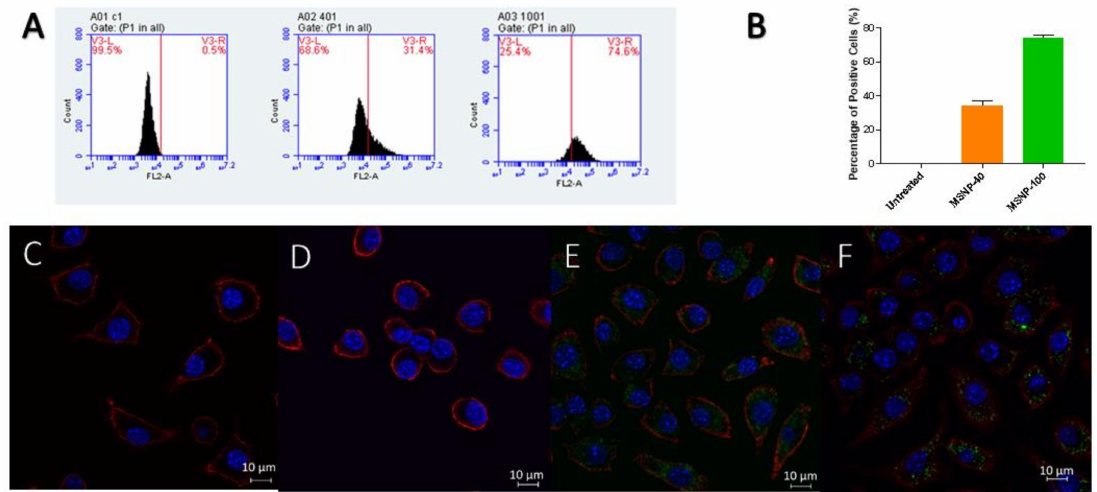
Figure 4. ( A ) Raw data obtained from fluorescence-activated cell sorter (FACS) indicating the shift in fluorescence intensity (Note: Graphs shown are only from one sample). C1 = untreated, 401 = MSNP-40, 1001 = MSNP-100. ( B ) Uptake of rhodamine-loaded MSNP quantified by FACS ((mean ± SD, n = 3). ( p < 0.05 for MSNP-40 compared to MSNP-100). ( C – F ) Laser scanning confocal microscopy (LCMS) images of ( C , D ) untreated cells, ( E ) MSNP-40 and ( F ) MSNP-100. Nuclei were stained with DAPI (Blue), MSNP were stained with rhodamine (Green) and the cell cytoskeleton was stained with wheat germ agglutinin—Alexa fluor 633